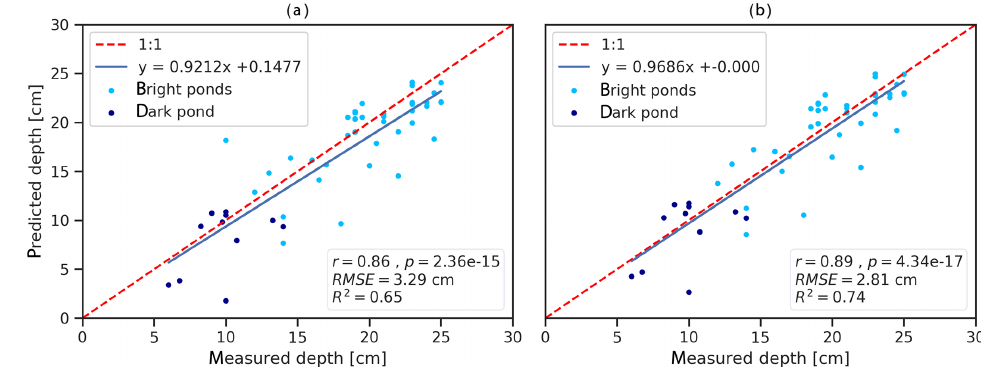
Figure 11. Measured versus predicted depth for the entire dataset (a) with outlier removed and offset correction (b) .